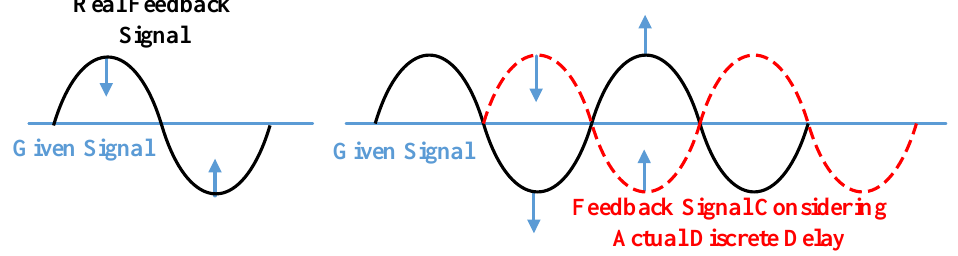
Figure 10. Qualitative analysis schematic diagram of resonance generation mechanism.